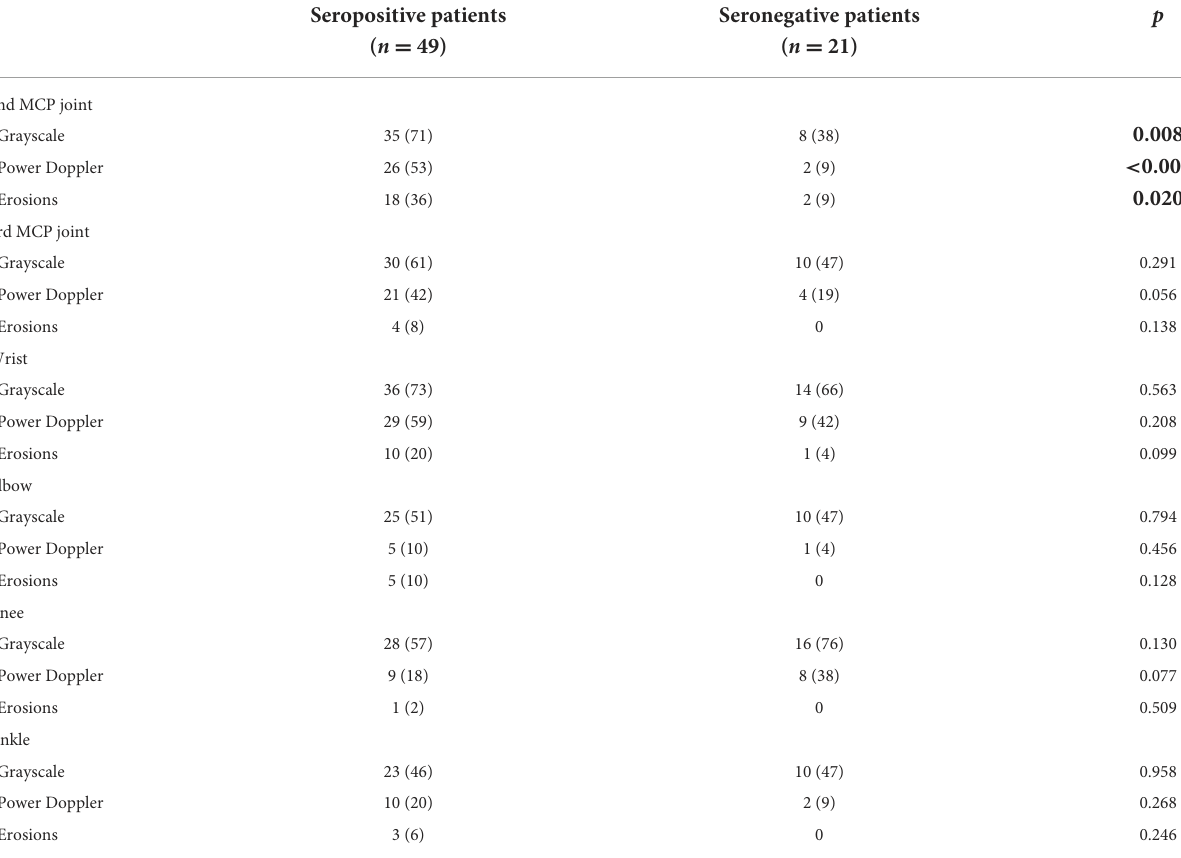
TABLE 3 Pathological findings observed on ultrasound in 12 main joint